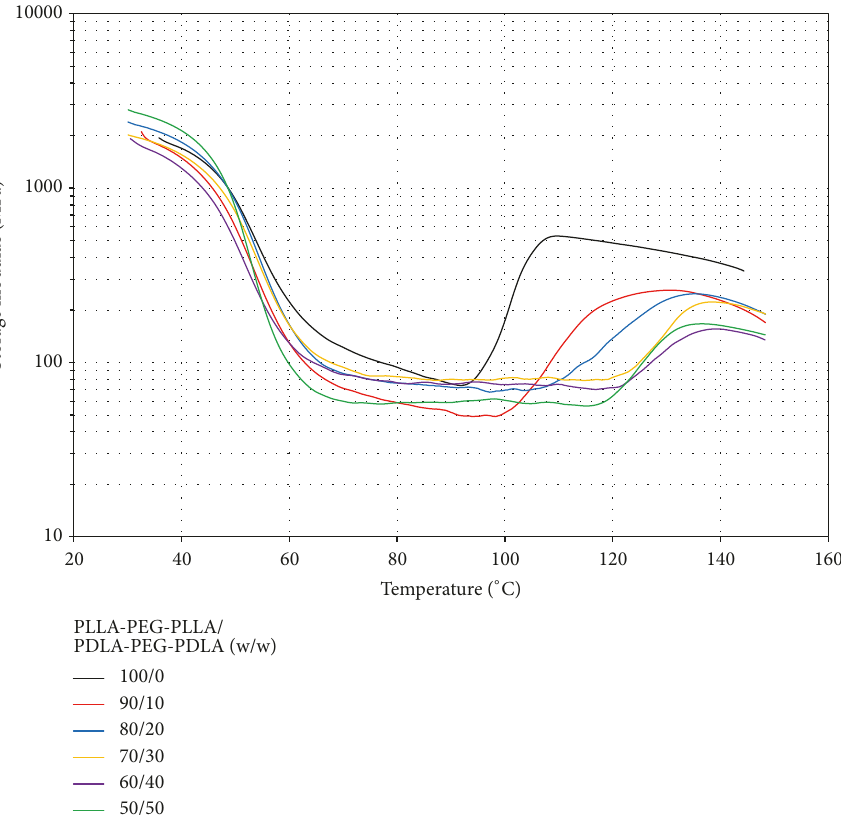
Figure 8: Storage modulus from DMA analysis of PLLA-PEG-PLLA/PDLA-PEG-PDLA blend films.